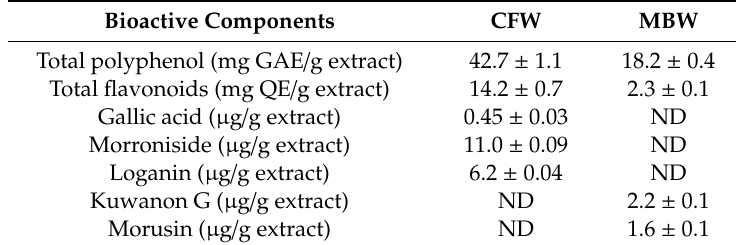
Table 1. Contents of polyphenols and flavonoids in water extract of Cornus o ffi cinalis fruits (CFW) and Morus alba root bark